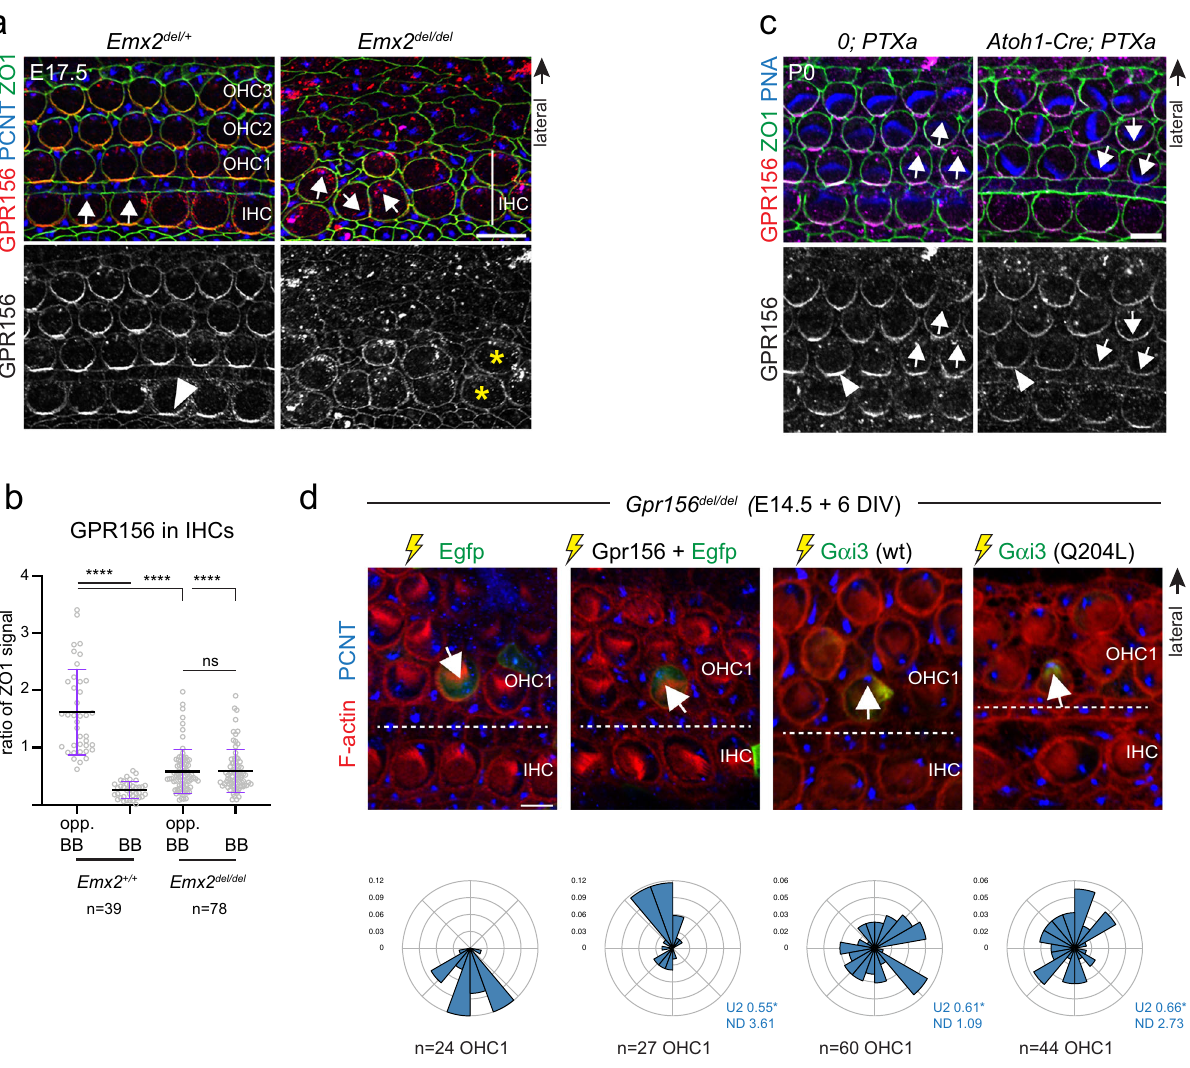
Fig. 6 EMX2 > GPR156 > G α i epistasis and HC-autonomous GPR156> G α i function in the mouse auditory organ. a E17.5 cochleae labeled with GPR156, ZO1, and PCNT. Polarization of GPR156 in IHCs (arrowhead) is lost in Emx2 mutants (asterisks), and OHCs are missing (see Supplementary Fig. 6e). b GPR156 enrichment in IHCs. GPR156 enrichment is measured at the junction opposite (opp. BB) or near (BB) the basal body labeled with PCNT in the same HC. GPR156 is expressed as ratio of ZO1 signal (mean ± SD; n , HC numbers in 3 or more animals; Kruskal-Wallis test, **** p < 0.0001, ns p > 0.9999). c P0 cochleae labeled with GPR156, ZO1 and peanut agglutinin (PNA). GPR156 is polarized normally (arrowheads) when G α i is inactivated by PTXa and OHCs show graded inversion by row. d Functional rescue of OHC1 orientation in Gpr156 del/del cochlear explants. The constructs indicated were electroporated at E14.5, and the cochleae explanted and cultured for 6 days in vitro (DIV). The orientation of one electroporated OHC1 (green Egfp or G α i3 signal) is indicated (arrows). Circular histograms show electroporated OHC1 orientation as a frequency distribution for the constructs indicated (20° bins in a referential where 90° (top) is lateral and 0° (right) is towards the cochlear base; n indicates OHC1 number in 10 or more explants representing 2 or more independent experiments; Watson U2 test of homogeneity; normalized difference (ND) value indicates how many standard deviations separate the circular means of each distribution). Note that Egfp and Gpr156 co-electroporation does not guarantee that Egfp + OHC1 express Gpr156, probably explaining why some are not rescued. Arrows indicate HC orientation based on PCNT-labeled basal body ( a , d ) or PNA-labeled OHC hair bundle ( c ). In c best focus stack slice for PNA signal was combined with lower focus slice for GPR156-ZO1. Scale bars are 10 µ m ( a ), 5 µ m ( c , d ).